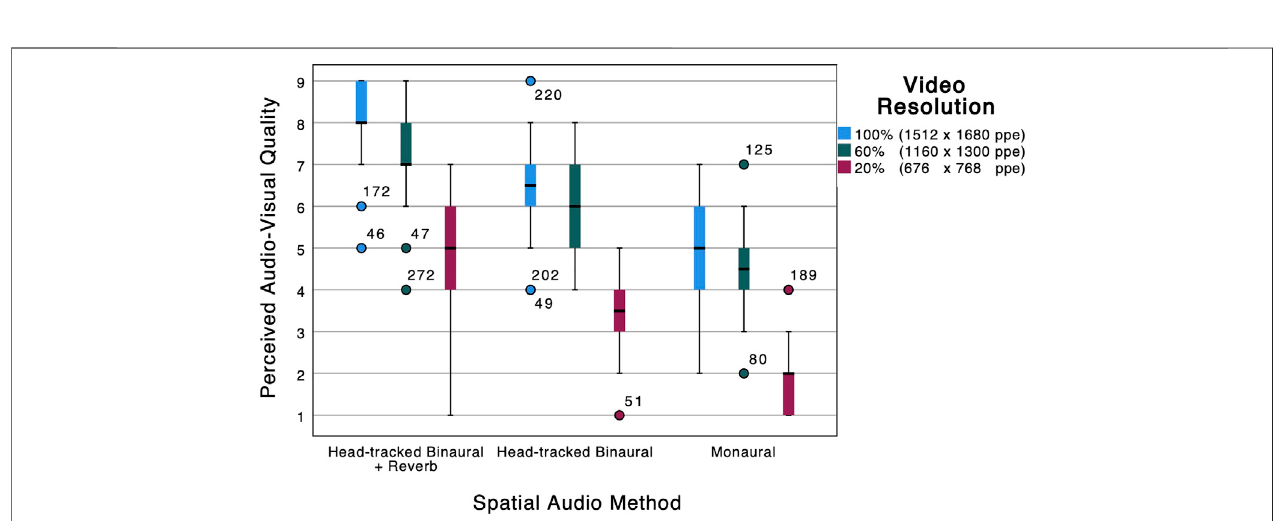
FIGURE 5 | Box plot of perceived audio-visual quality against video resolution and spatial audio method.